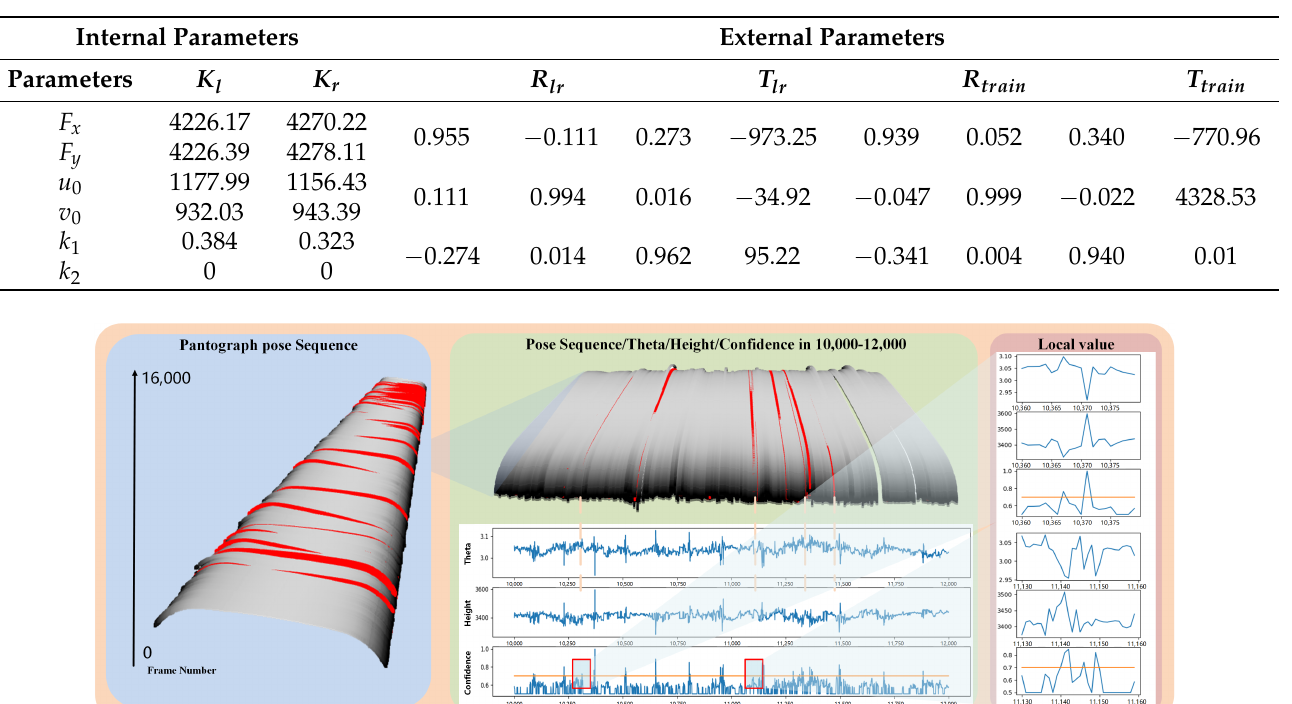
Table 3. Calibration results in physical experiment.